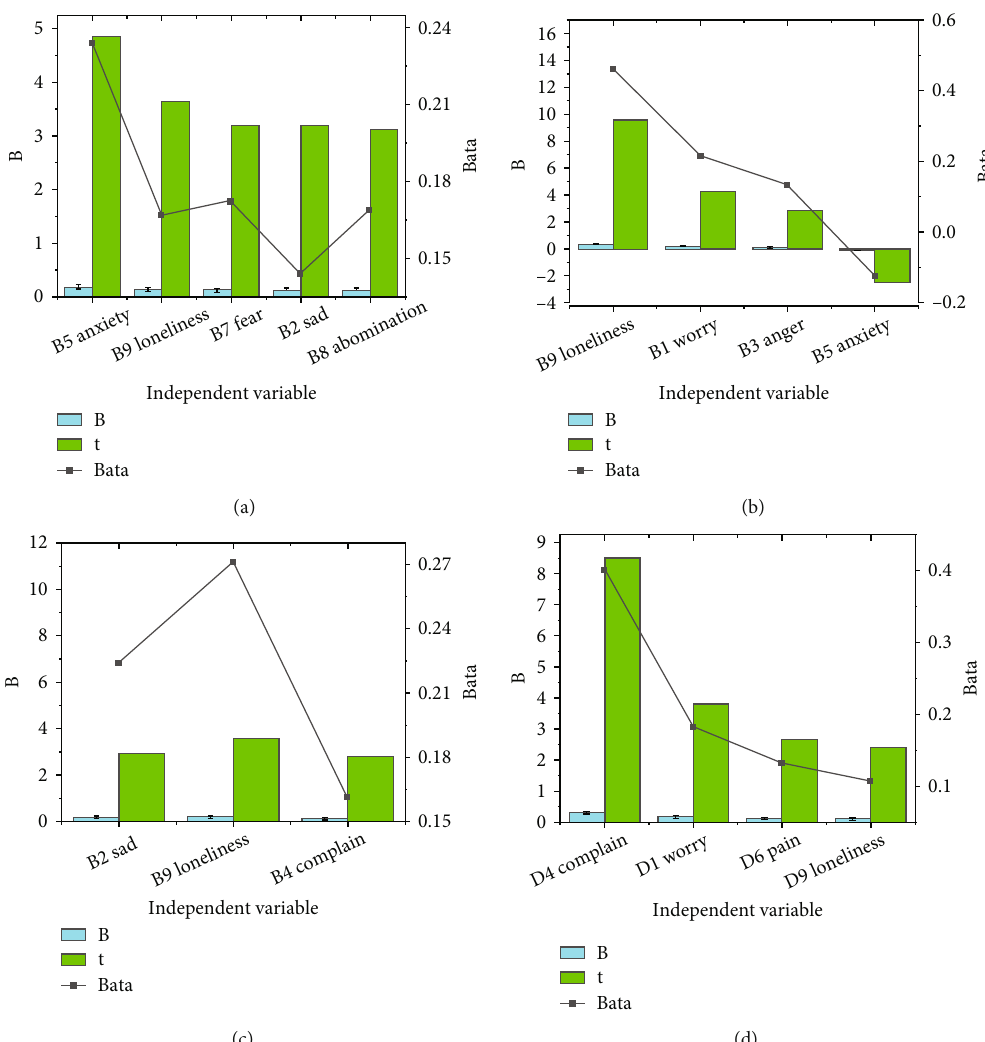
Figure 7: QS results of alleviation e ff ects of di ff erent music styles on negative emotions around the world ((a) regression analysis of “ someone like you ” ; (b) regression analysis of “ Electronic Synthetic Music ” ; (c) regression analysis of “ Suddenly ” ; (d) regression analysis of “ Dhyana ” ; B represents the nonstandardized coe ffi cient; t denotes the emotional